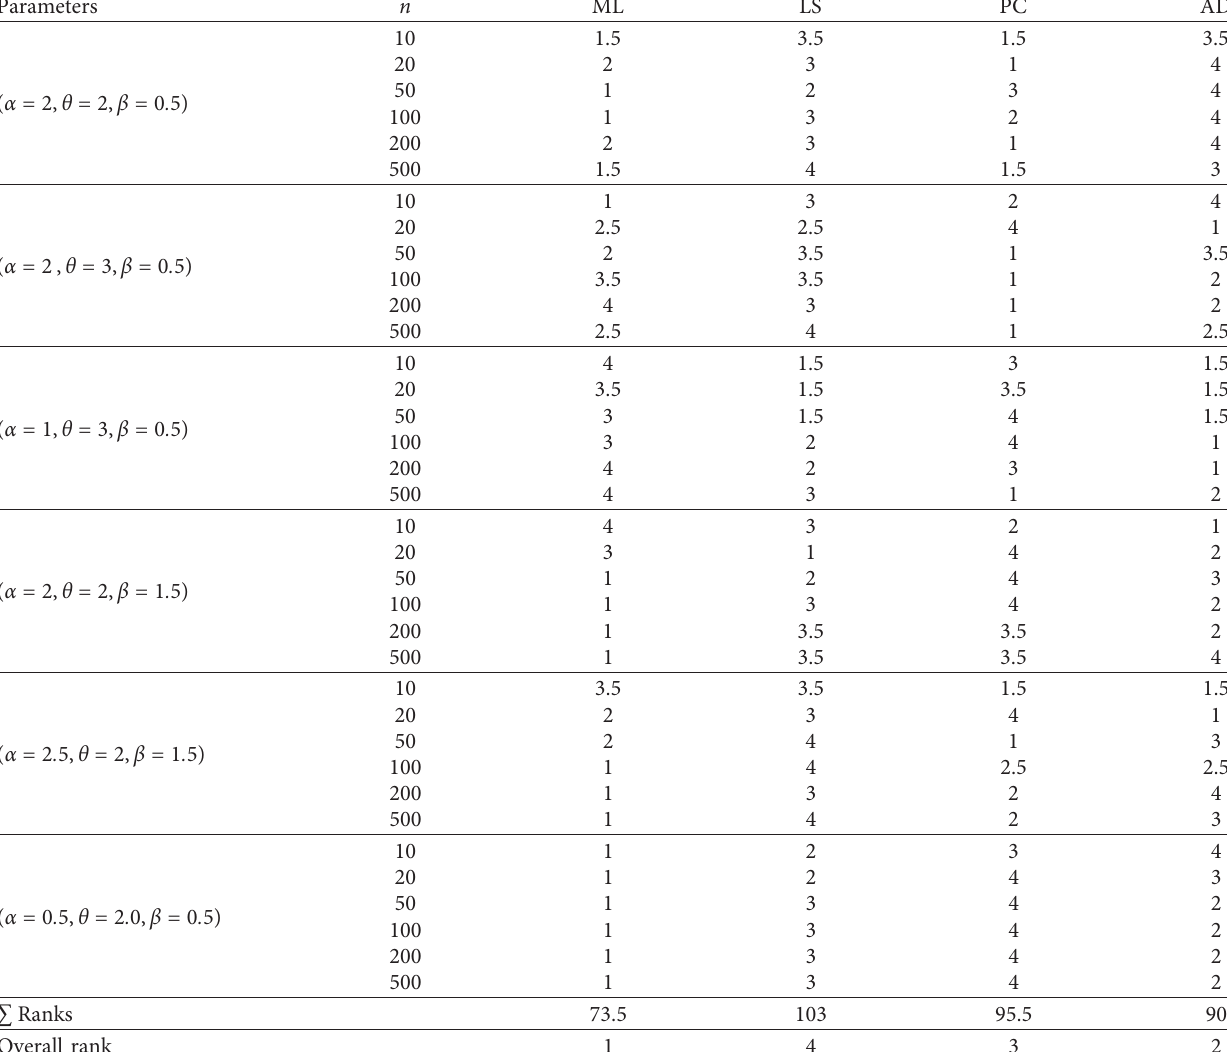
Table 8: Partial and overall ranks of all the methods of estimation for some combinations of parameters. Parameters n ML LS PC